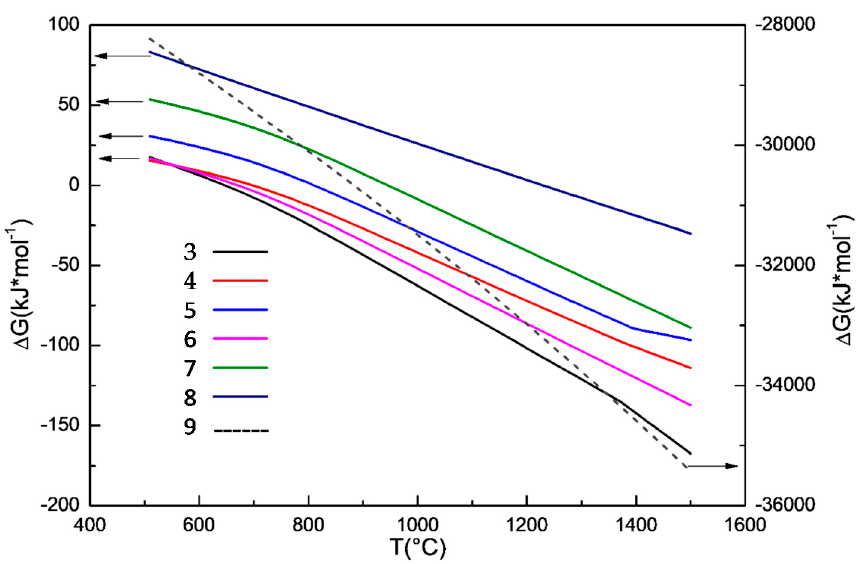
∆ G vs. temperature of Equations Figure 6. Plots of Δ G vs. temperature of Equations (3–9). Figure 6. Plots of